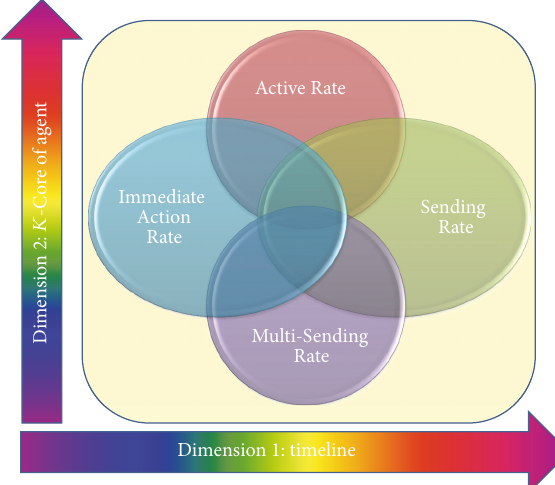
Figure 5: Dynamic user transition